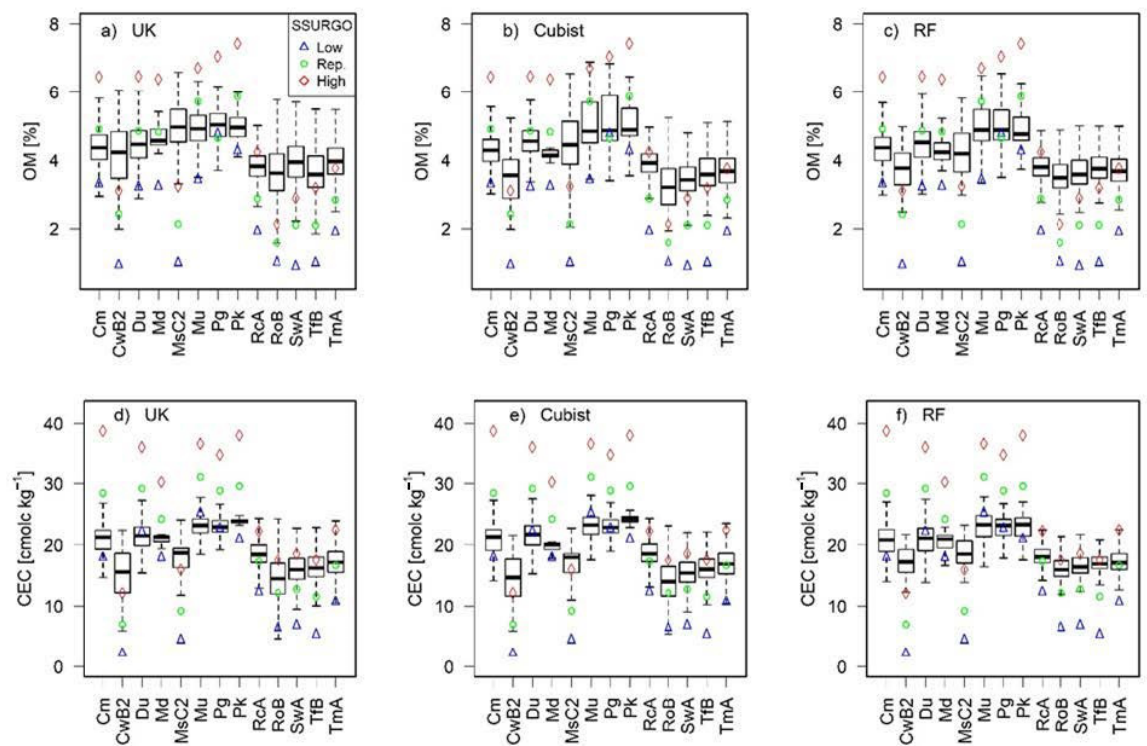
Figure 9. Box-plots of model predicted values of soil organic matter content (SOM) and cation exchange capacity (CEC) for each SSURGO map unit. The boxplots of ( a – c ) show SOM and ( d – f ) show CEC prediction based on universal kriging (UK), Cubist, and random forest (RF), respectively. Triangles show low (Low), rhombuses show high (High) and circles show representative (Rep) values of SOM and CEC for each SSURGO map unit.